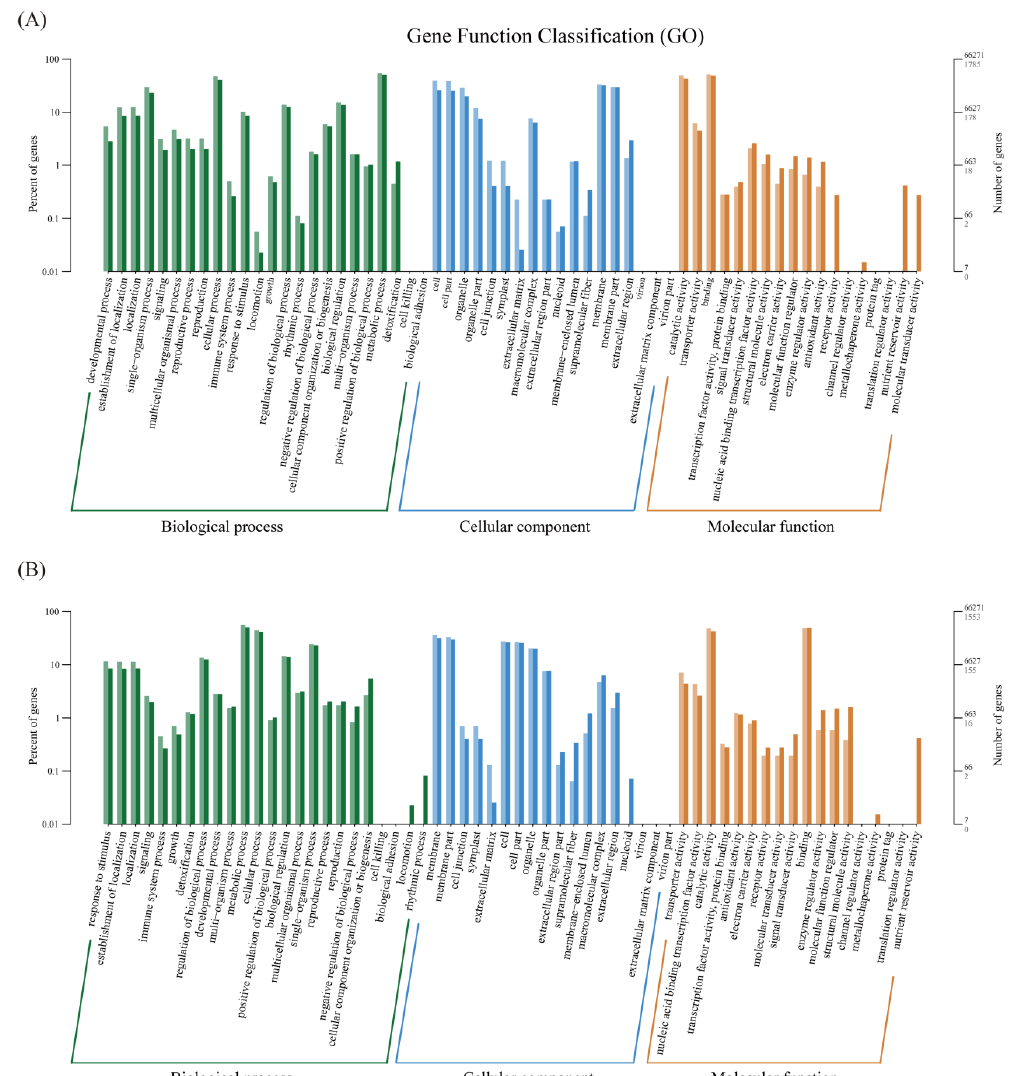
Figure 3. GO enrichment analysis of the DEGs in drought-tolerant and drought-sensitive genotypes. ( A ): drought-tolerant genotype Jimai No. 47; ( B ) drought-sensitive genotype Yanzhan No. 4110.